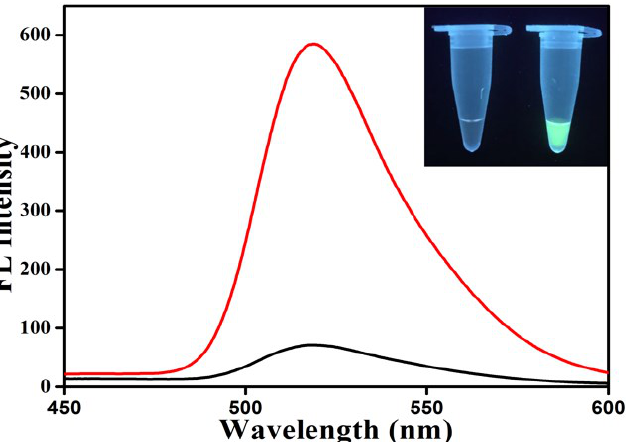
Figure 3. The fluorescence spectra of extracted HPV16 DNA and nuclease-free H 2 O after LAMP reaction. Red line: fluorescence spectra of extracted HPV16 DNA after LAMP reaction. Black line: fluorescence spectra of nuclease-free H 2 O after LAMP reaction.